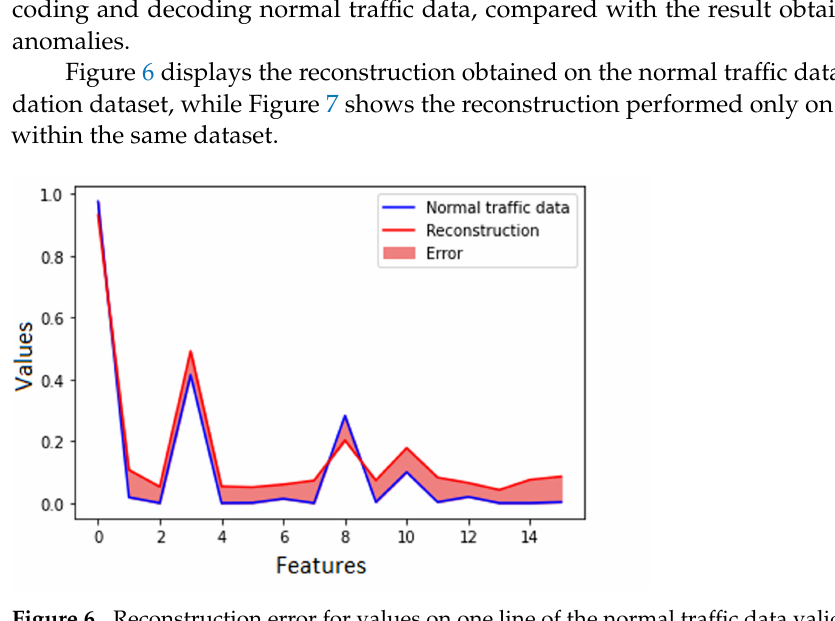
Figure 6. Reconstruction error for values on one line of the normal traffic data validation subset.